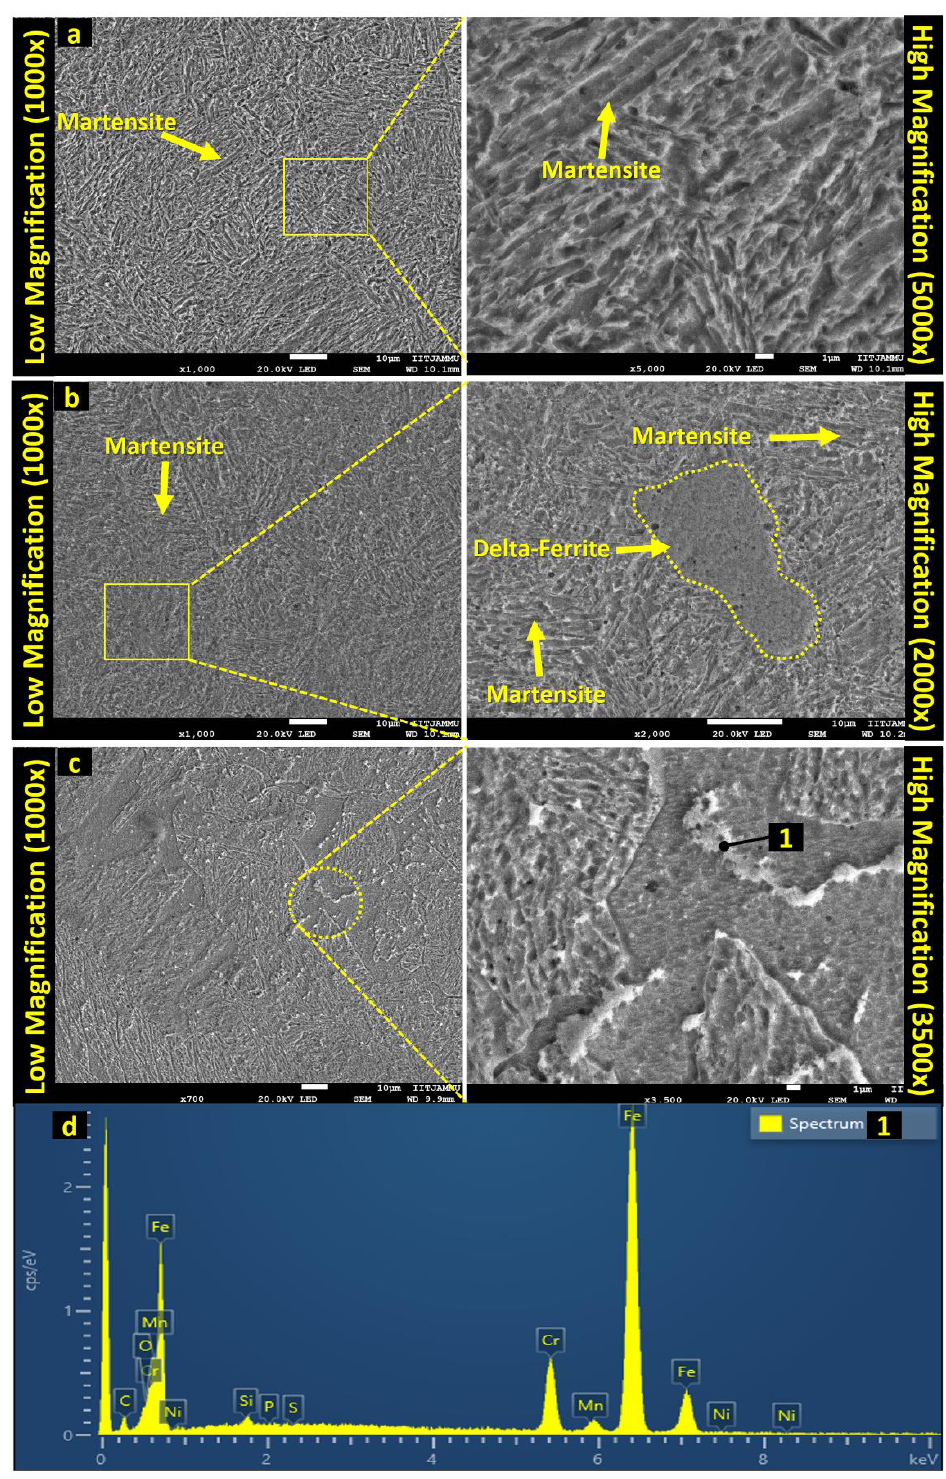
Figure 15. The ( a – c ) SEM image of the samples at different positions and ( d ) EDS analysis of the precipitates developed using the CMT − based WAAM process (dashed line represent delta − ferrite).